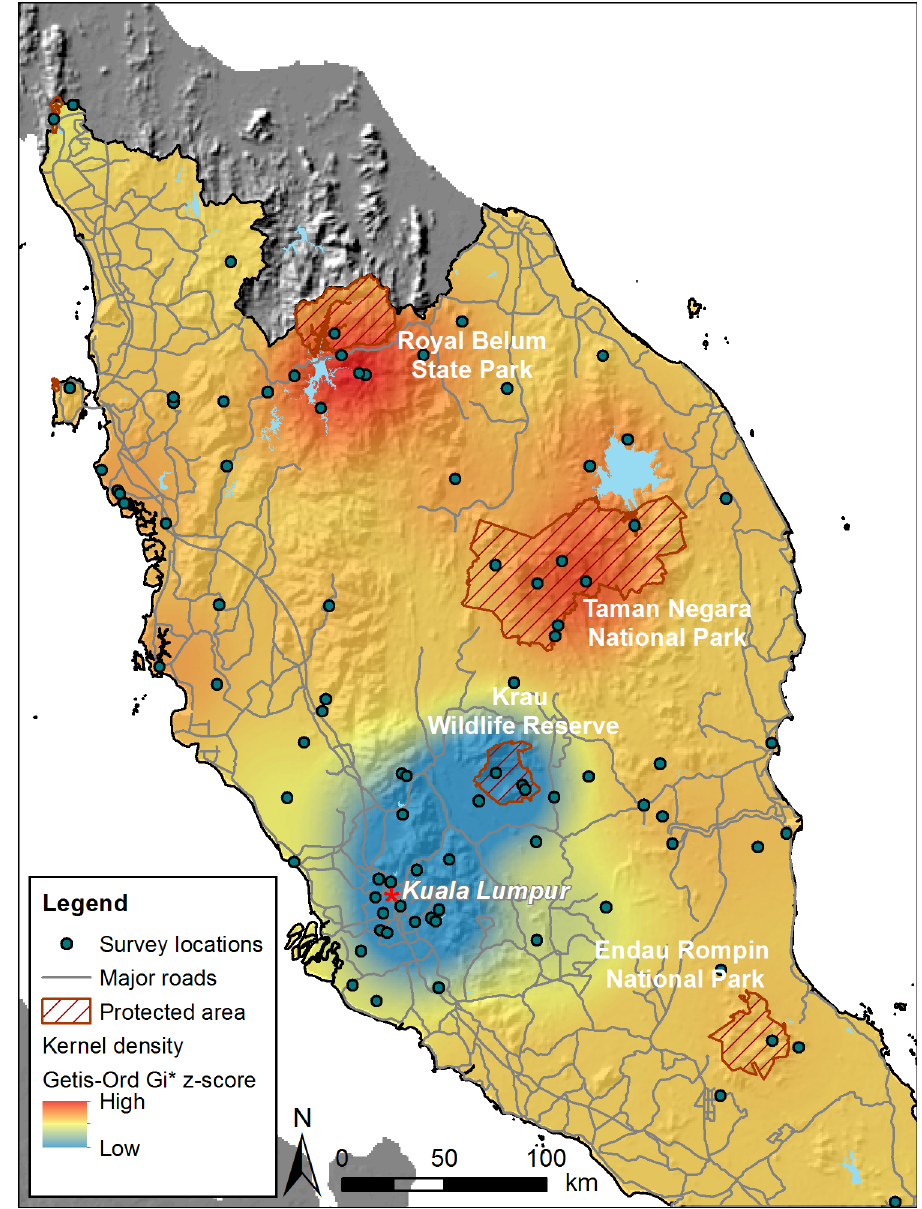
Fig 4. Locations of mammalian carnivore surveys and kernel density surface of Getis-Ord Gi (cid:3) z scores of weighted ranking of IUCN red list categories for recorded species locations in Peninsular Malaysia, 1948–2014. Hillshade layer derived from Shuttle Radar Topography Mission (STRM) 90-m Digital Elevation Data from Consultative Group on International Agricultural Research (CGIAR) and reprinted under a CC BY license, with permission from International Center for Tropical Agriculture (CIAT), original copyright 2004. Protected areas mentioned in the text are labeled; reprinted from World Database on Protected Areas (http://www.protectedplanet.net) under a CC BY license, with permission from the United Nations Environmental Programme-World Conservation Monitoring Centre, original copyright